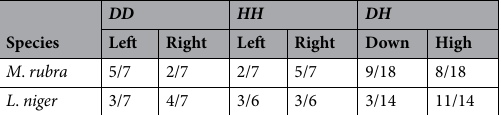
Table 2. First food source discovered in the DD , HH and DH conditions.